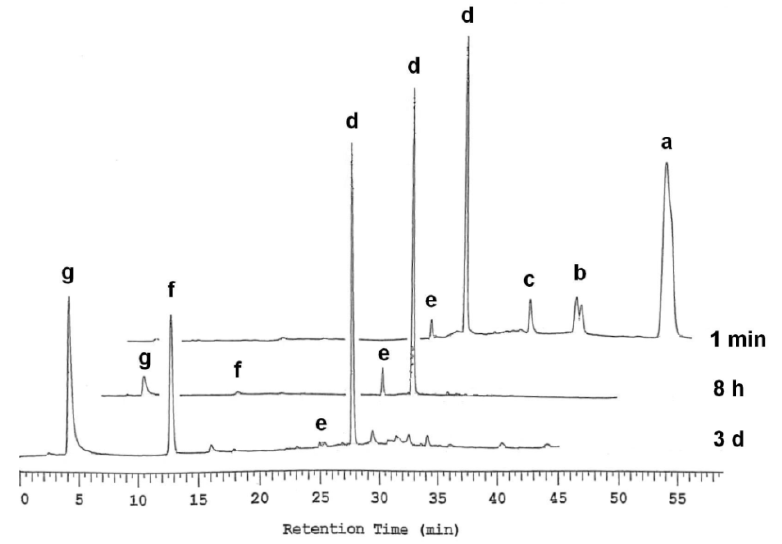
Figure 1. RP-HPLC profiles for the HLE-catalyzed hydrolysis of thymidine 5´-bis[3- acetyloxy-2-cyano-2-(2-phenylethylcarbamoyl)propyl]phosphate ( 1 ) at pH 7.5 and 37.0 °C ( I = 0.1 mol L -1 with NaCl). Notation: (a) 1 , (b) 14 , (c) 15 , (d) 4 , (e) 16 , (f) thymidine